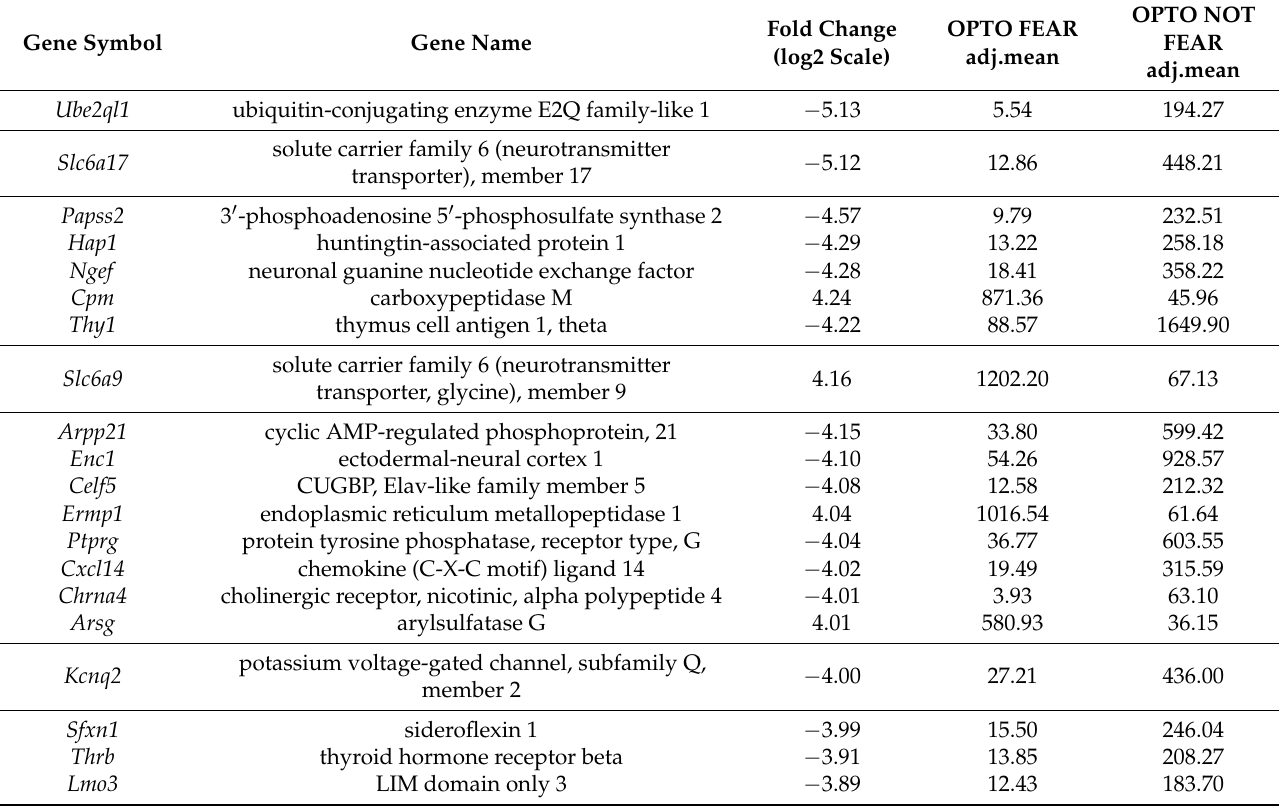
Table 3. The top 20 DEGs identified by differential expression profiling from RNA extracted by amygdala pyramidal neurons Comparison between OPTO FEAR vs. OPTO NOT FEAR